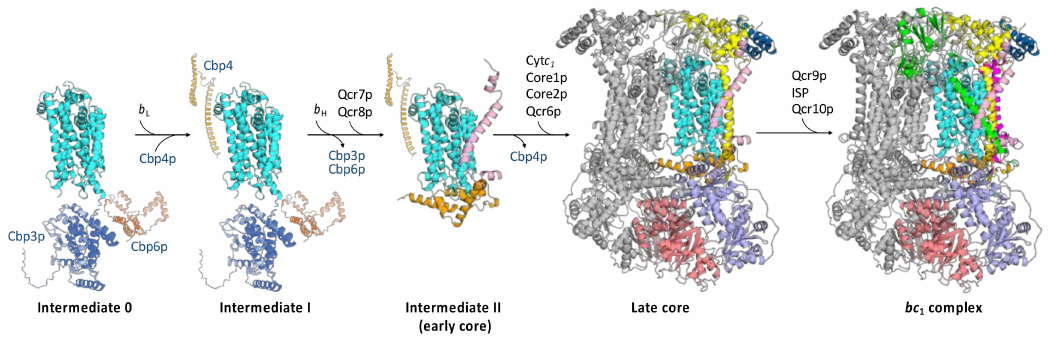
Figure 3. Schematic model depicting the putative multi-step assembly of the mitochondrial bc 1 complex (cytochrome b : aquamarine, cytochrome c 1 (Cyt c 1 ): yellow, ISP: green, core protein 1 (Core1p): light blue, core protein 2 (Core2p): salmon, Qcr6p: sky blue, Qcr7p: orange, Qcr8p: pink, Qcr9p: magenta). Cbp3p, Cbp4p and Cbp6p structures were obtained from the UniProt database (https://www.uniprot.org) (accessed on 24 August 2022) using the protein structure prediction tool AlphaFold. The interaction sites between chaperone proteins and bc 1 subunits remain